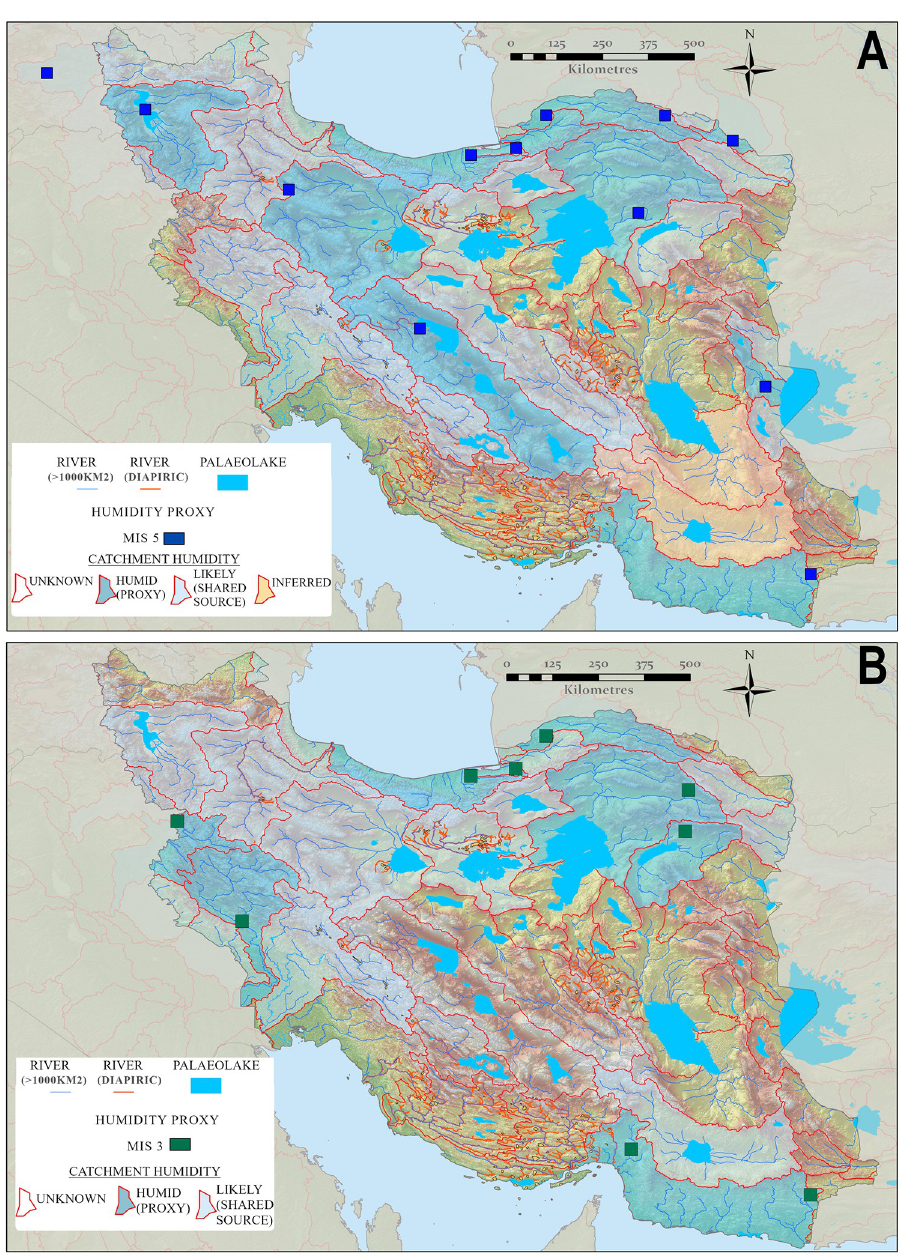
Fig 6. Hydrologically active catchments during MIS 5 (A) and MIS 3 (B), based upon dated proxies which reflect enhanced humidity. Dated proxies such as lakes and rivers reflect an accumulation of overland flow from upland areas, where this is the case adjacent catchments containing hydrological networks originating in the same uplands are also displayed as likely humid. Map created by one of our authors (PSB).